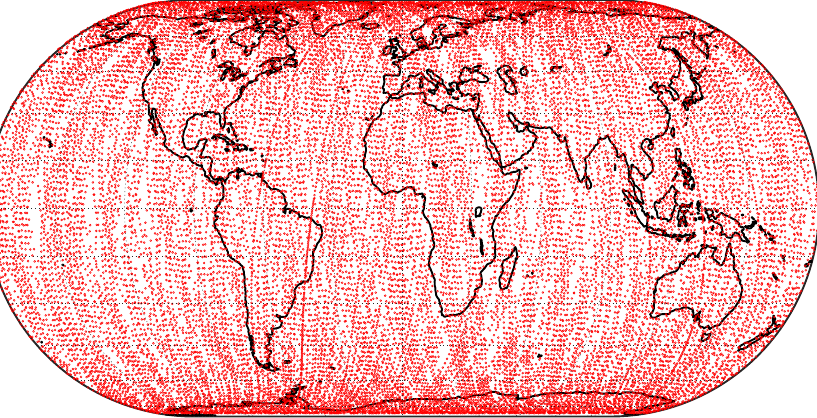
Figure 7. Location (latitude and longitude) of UVSQ-SAT observations (red colored dots on the world map) during the month of February